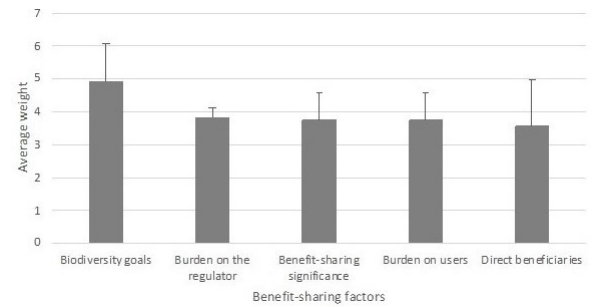
Figure 2. Average weight assigned by interviewees to the five different benefit-sharing factors considered. Error bars indicate standard deviation of the